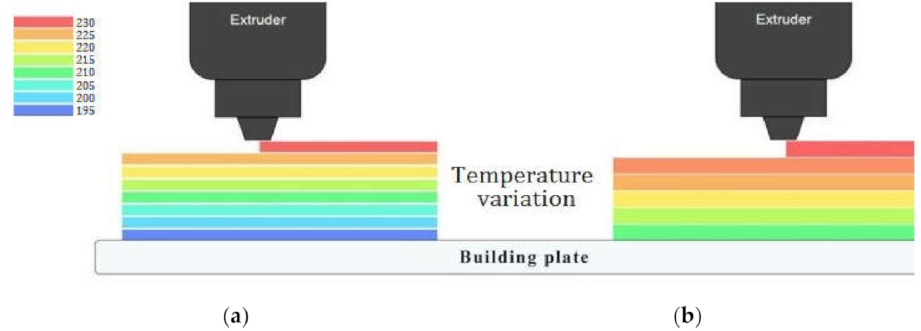
Figure 8. Temperature variation in ( a ) lower LT and ( b ) higher LT.